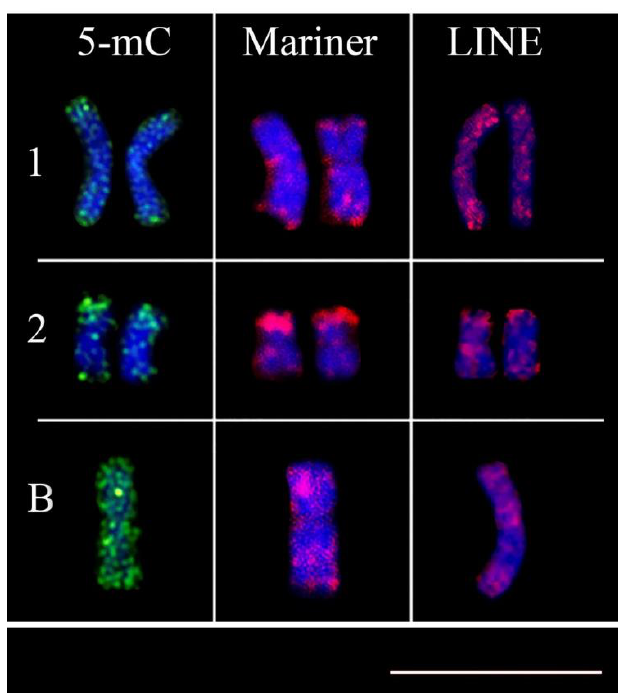
Figure 3. Association of immunodetection of methylated DNA and transposable elements. n the first